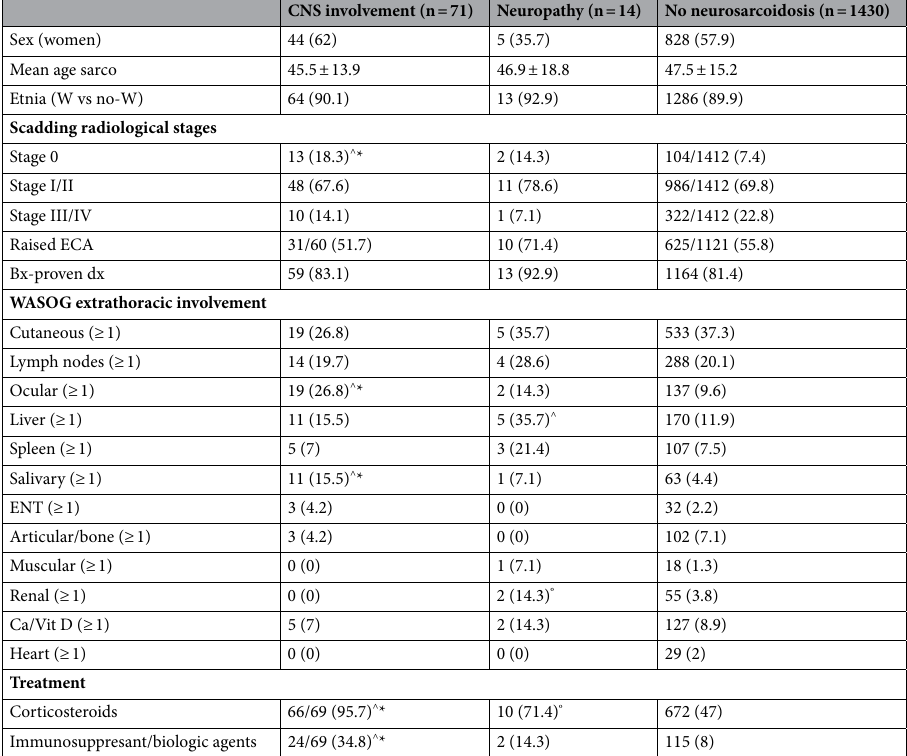
Table 3. Phenotypic differences according to the presence or absence of neurosarcoidosis in patients with CNS neurosarcoidosis and in those with PNS neurosarcoidosis. ^ p value < 0.05 in comparison with patients without neurosarcoidosis. *q value < 0.05 in comparison with patients without neurosarcoidosis. º p value < 0.05 in comparison with patients with CNS